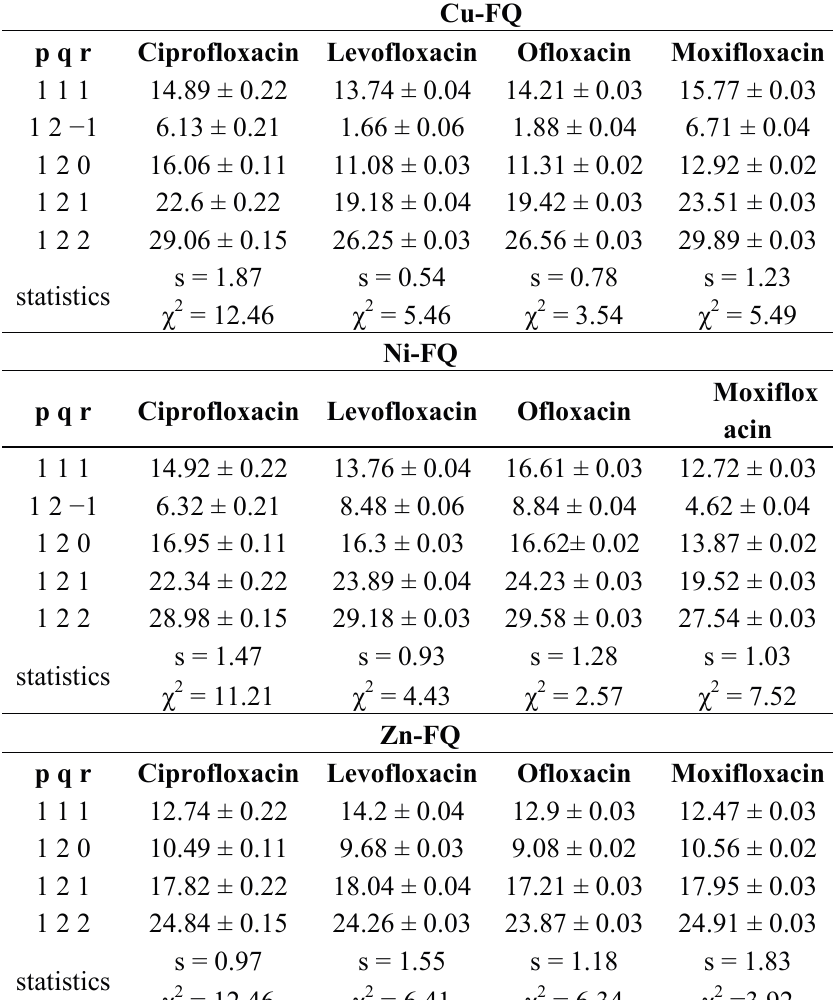
± SD ) for complexes present pqr